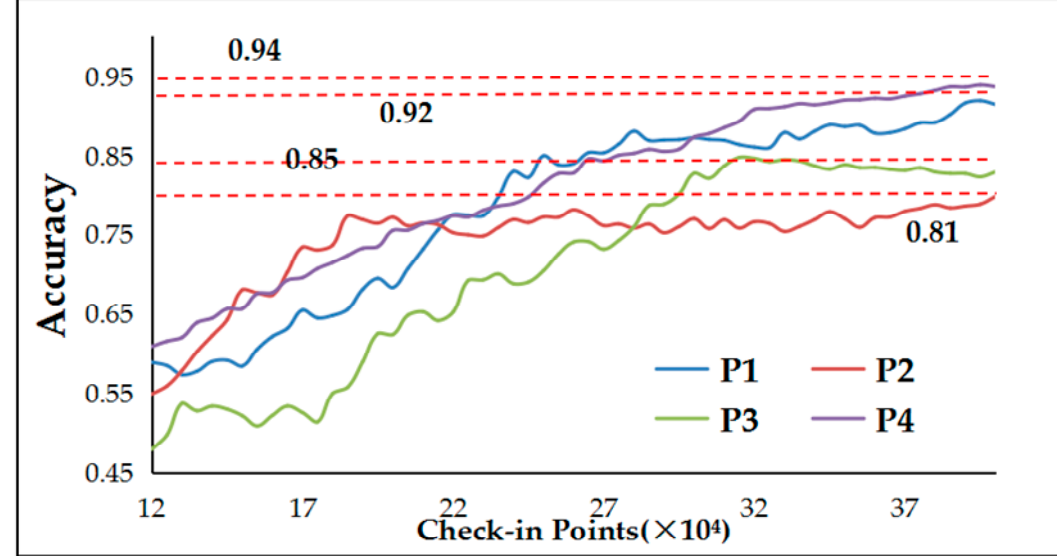
Figure 13. Accuracy of the model with check-in data acquired in different time periods. During P4(19:00–23:00) and P1(23:00–8:00), the ratio of check-in data produced in residential